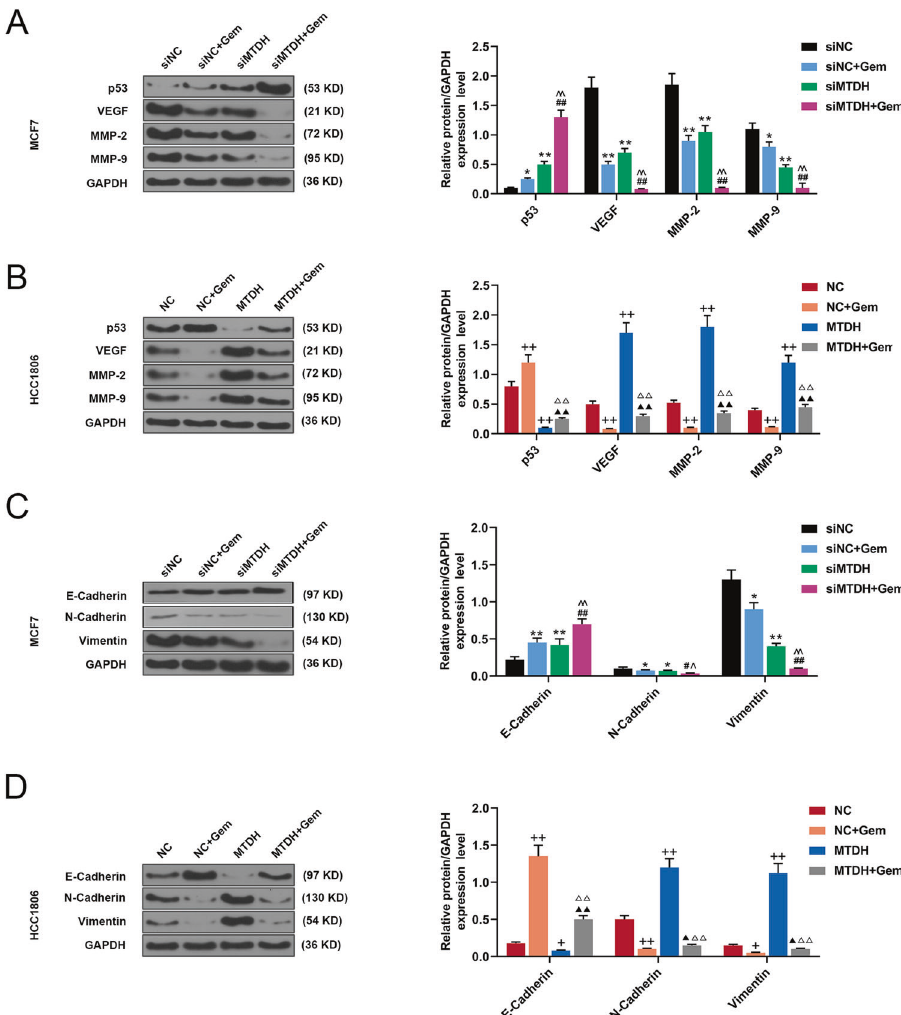
Fig. 4 The effects of MTDH on protein expressions of Gem-treated breast cancer cells. A The effects of silenced MTDH on expressions of p53, VEGF, MMP-2, and MMP-9 in MCF7 cells were detected by Western blot ( n = 3, * P < 0.05, ** P < 0.01, vs. siNC; ## P < 0.01, vs. siNC + Gem; ^^ P < 0.01, vs. siMTDH). B The effects of overexpressed MTDH on expressions of p53, VEGF, MMP-2, and MMP-9 in HCC1806 cells were detected by Western blot ( n = 3, ++ P < 0.01, vs. NC; ▲▲ P < 0.01, vs. NC + Gem; △△ P < 0.01, vs. MTDH). C The effects of silenced MTDH on expressions of E-Cadherin, N-Cadherin, and Vimentin in MCF7 cells were detected by Western blot ( n = 3, * P < 0.05, ** P < 0.01, vs. siNC; ## P < 0.01, vs. siNC + Gem; ^^ P < 0.01, vs. siMTDH). D The effects of overexpressed MTDH on expressions of E-Cadherin, N-Cadherin, and Vimentin in HCC1806 cells were detected by Western blot ( n = 3, + P < 0.05, ++ P < 0.01, vs. NC; ▲ P < 0.05, ▲▲ P < 0.01, vs. NC + Gem; △△ P < 0.01, vs. MTDH). VEGF vascular endothelial growth factor, MTDH Metadherin, NC negative